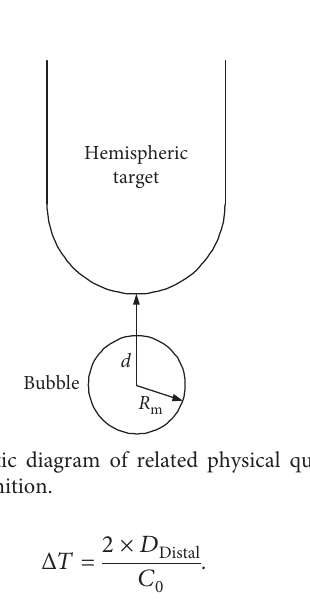
Figure 3: Maximum radius of the bubble is about 30mm by a discharge of 400V in a free field.